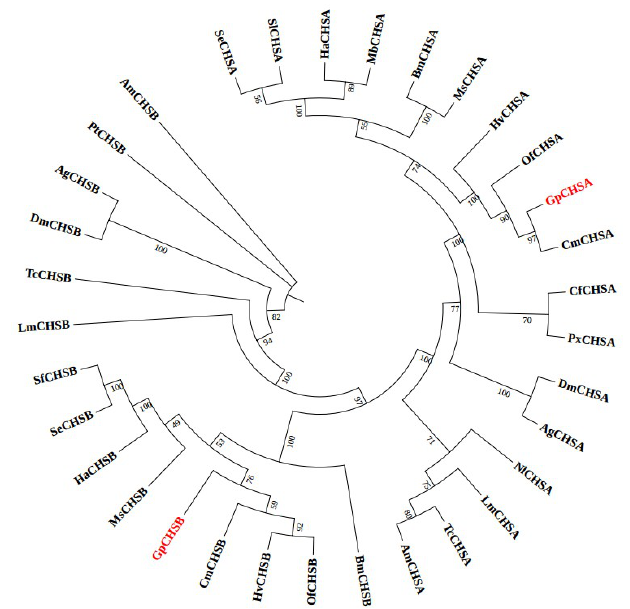
Figure 3. Phylogenetic relationship analysis of CHSs in different identified insect species using the neighbor-joining method with 1,000 bootstraps. Bm, Bombyx mori ; Cf, Choristoneura fumiferana ; Cm, Cnaphalocrocis medinalis ; Dm, Drosophila melanogaster ; Ha, Helicoverpa armigera ; Lm, Locusta migratoria ; Ms, Manduca sexta ; Px, Plutella xylostella ; Se, Spodoptera exigua ; Tc, Tribolium castaneum ; Of, Ostrinia furnacalis ; Sf, Spodoptera frugiperda ; Hv, Heortia vitessoides ; Ag, Anopheles gambiae ； Pt, Parasteatoda tepidariorum ; Am, Apis mellifera ; Mb, Mamestra brassicae ; Nl, Nilaparvata lugens; Sl, Spodoptera litura .